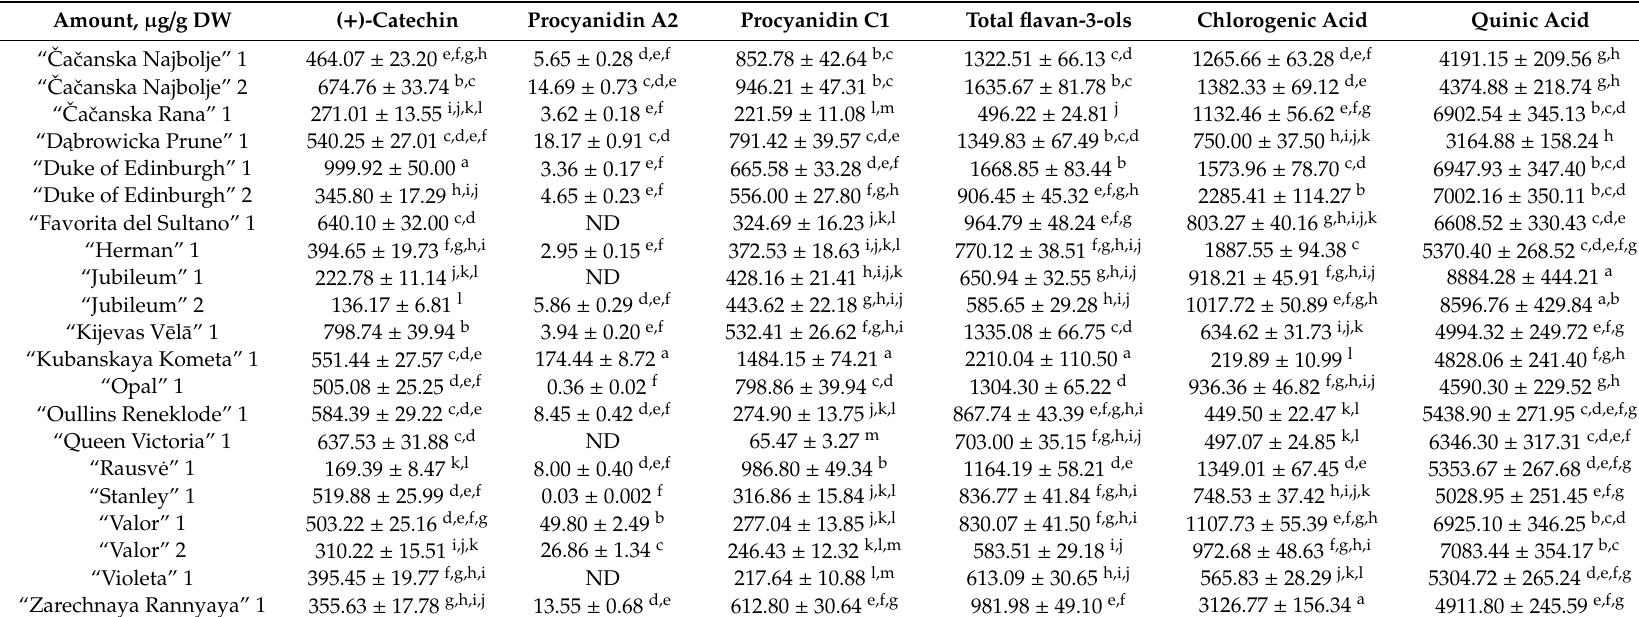
Table 2. Variability in the quantitative content ( µ g / g DW) of identified flavan-3-ols, chlorogenic and quinic acids in plum fruit samples; di ff erent letters indicate statistically significant ( p < 0.05) di ff erences between the quantitative values of these compounds in plum fruit samples of di ff erent cultivars.